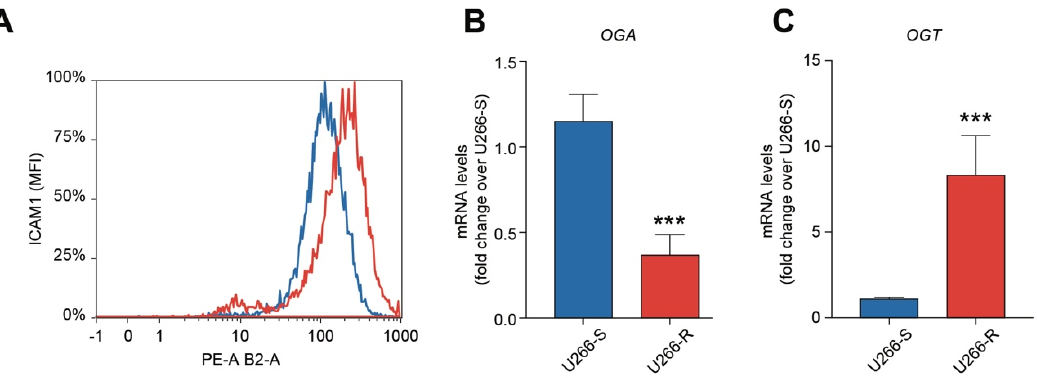
Figure 2. U266-R showed increased glycosylation. ( A ) Representative plot of ICAM1 cytofluorimetric analysis in U266-S and U266-R cell lines. ( B , C ) mRNA levels of O-GlcNAc transferase (OGA) and O-GlcNAc transferase (OGT) in U266-S versus U266-R cell lines; data are fold changes over U266-S and expressed as mean ± SEM of n ≥ 3 biological replicates; *** p -value < 0.001 versus U266-S.